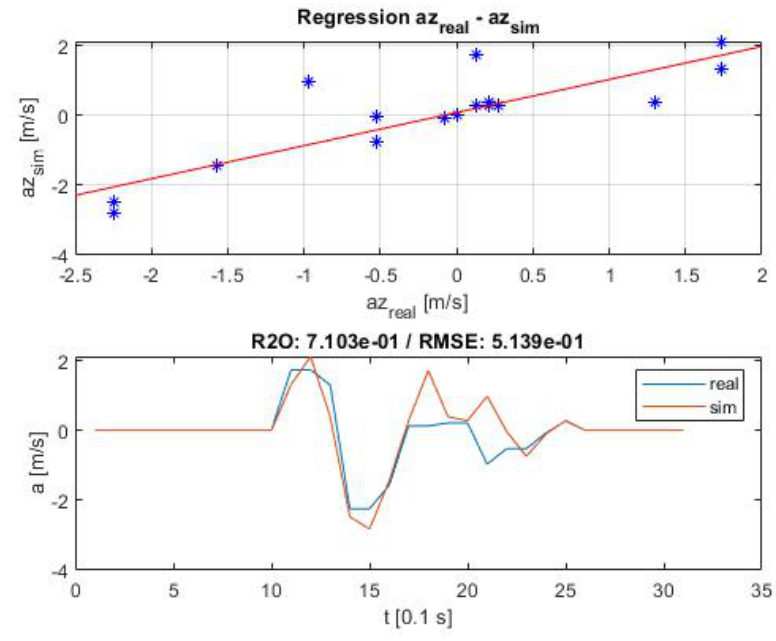
Figure A3. Validation of the z -acceleration in scenario 3 including ordinary R 2 and RMSE .